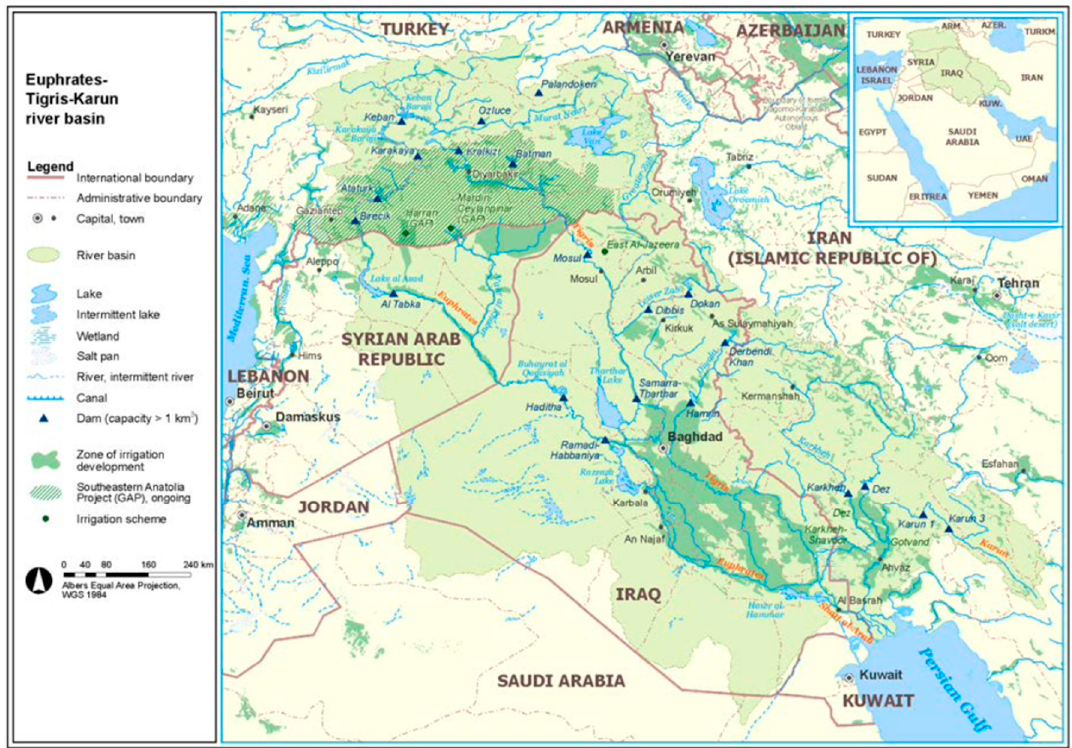
Figure 6. Drainage basin of the Mesopotamian Delta (Tigris, Euphrates and Karun Rivers) and major dams (modified from [65]).